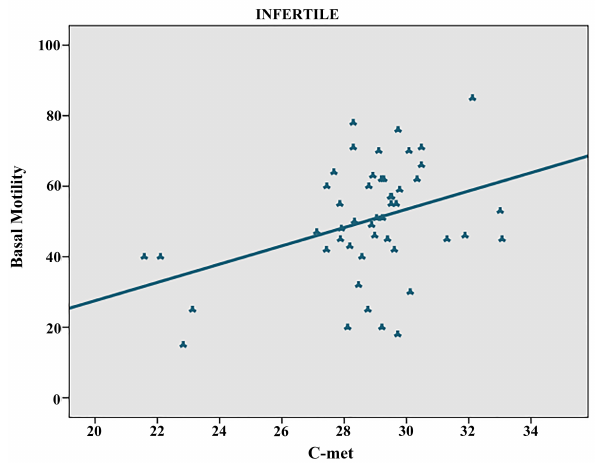
Fig. 3. Positive correlation between sperm motility percentage and c-Met expression level in the infertile group (r = 0.488, p =